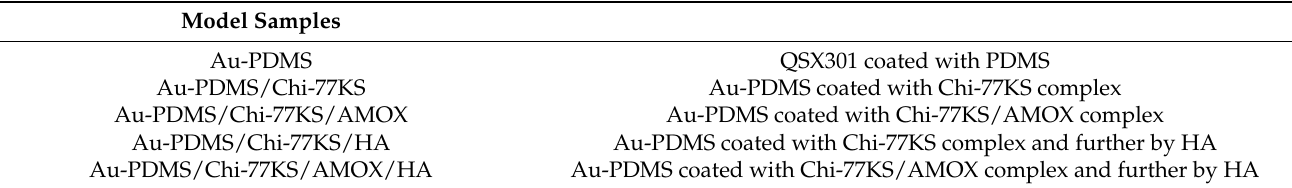
Table 1. QCM-D prepared samples and their abbreviations with descriptions.